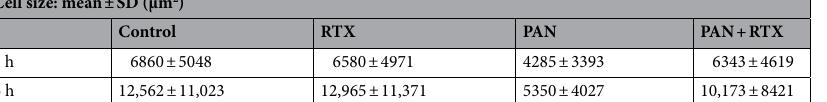
Cell size: mean ± SD (µm 2